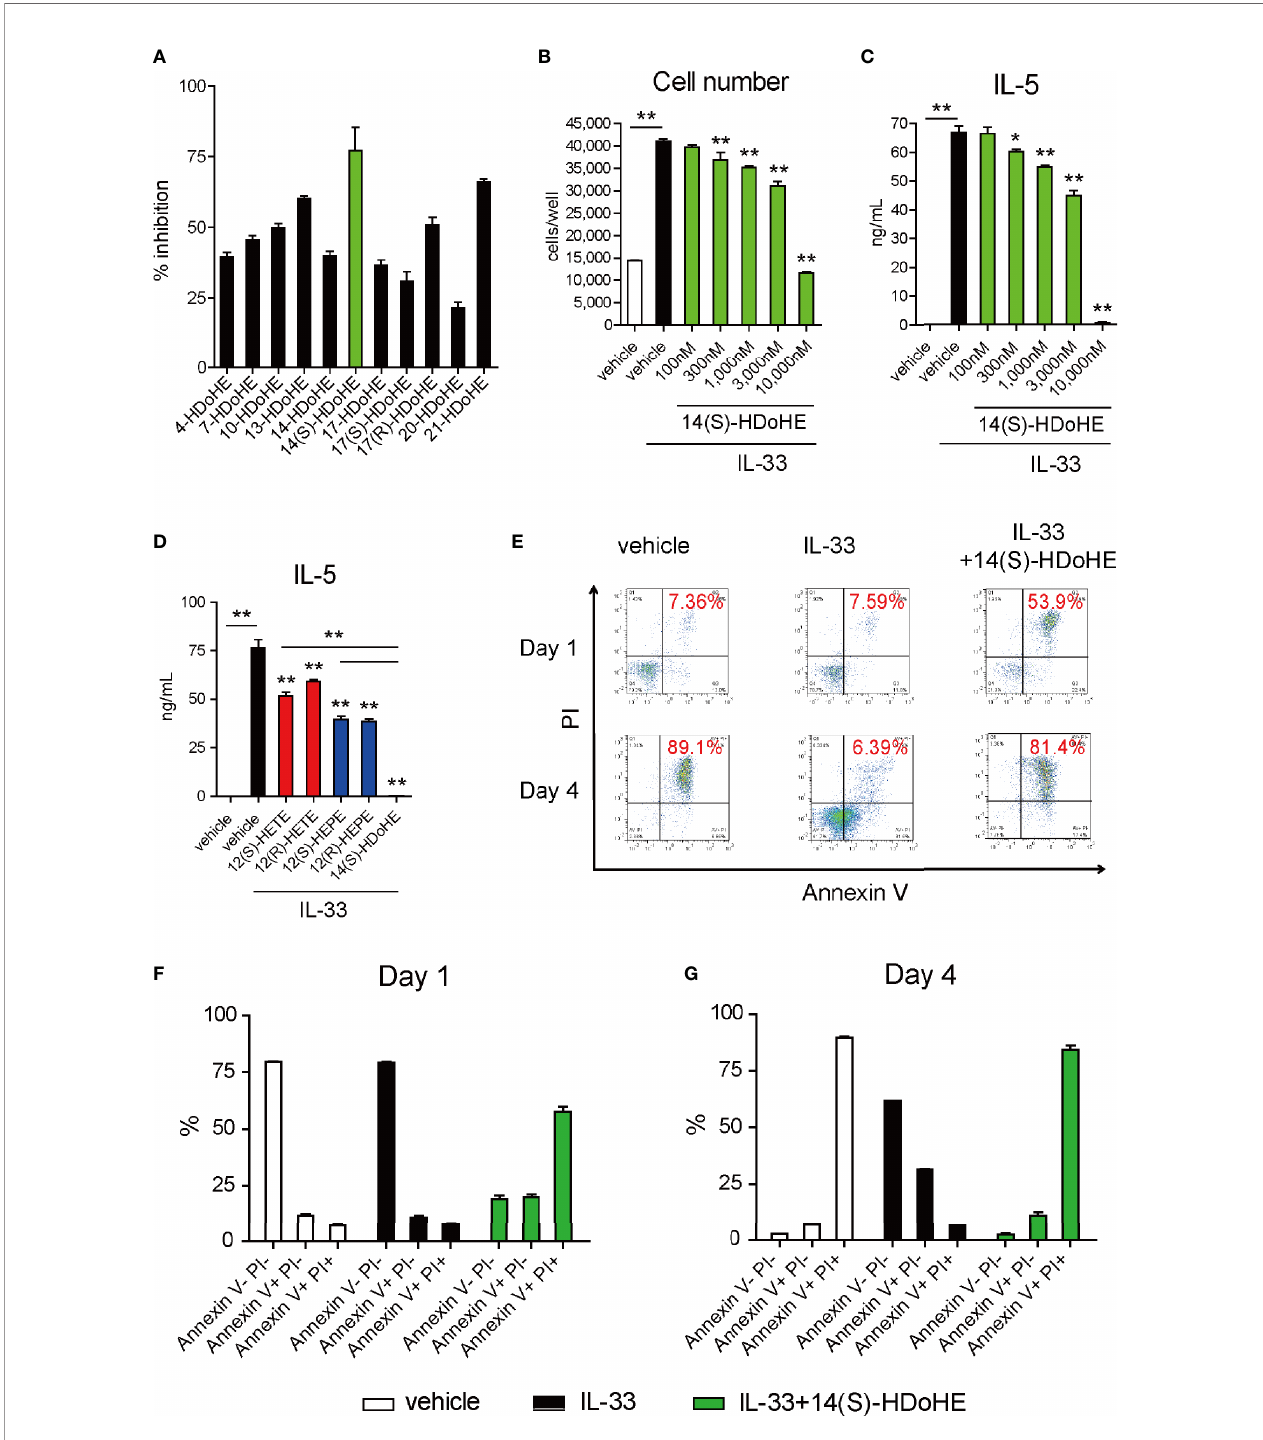
FIGURE 3 | 14(S)-HDoHE inhibit proliferation and cytokine production of ILC2s, with pro-apoptotic effects. ILC2 cells (10,000 cells per well) were cultured with IL-33 (10 ng/mL) for 1 or 4 days in the presence or absence of (A) DHA-derived monohydroxy-lipid metabolites (HDoHE, hydroxy docosahexaenoic acid: 10 -5 M) or (B – G) in the presence or absence of 14(S)-HDoHE (3 × 10 -7 – 10 -5 M: (B, C) ; or 10 -5 M: (D – G) , (D) 12-hydroxyeicosatetraenoic acid (HETE) and 12- hydroxyeicosapentaenoic acid (HEPE). The total cell count (A, B) and concentrations of IL-5 (C, D) in the culture supernatant were measured. (E – G) Flow cytometric analysis of Annexin V- and PI-stained ILC2 cells cultured with or without IL-33 (10 ng/mL) in the presence or absence of 14(S)-HDoHE (10 -5 M) for 1 or 4 days. The data are representative of three independent experiments. Mean ± SEM, n=3-8 for each group. *P < 0.05, **P < 0.01 (Student ’ s